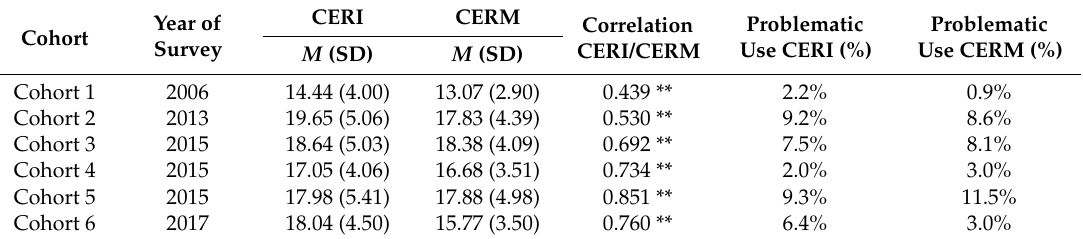
Table 5. Scores of the university student cohorts in the CERI and the CERM.